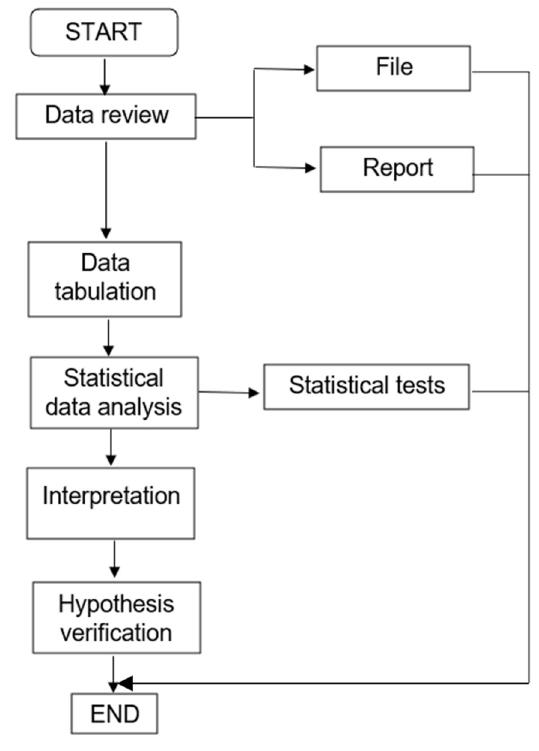
Figure 3. Data analysis process.